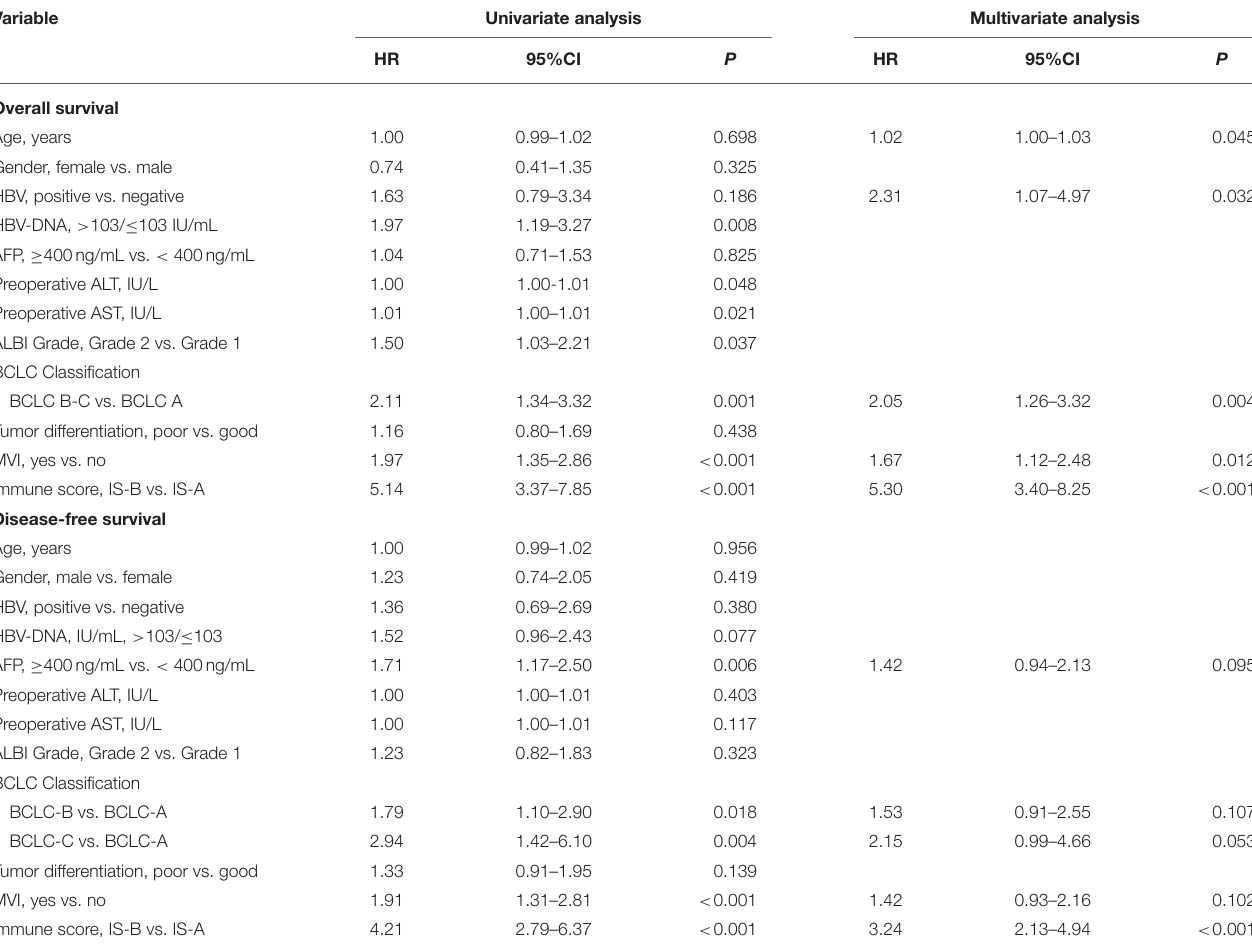
TABLE 2 | Univariate and multivariate analysis of the testing